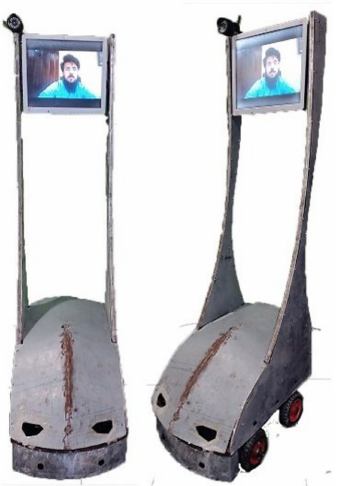
Figure 7. Manufactured Working Telepresence Robot Prototype. Our telepresence robot prototype is a robotic platform designed to facilitate remote communication and control in real-time. The proposed approach of the hybrid of DDQN and GRU can be implemented and tested on our manufactured robot to gather data and compare its performance with other approaches. The telepresence robot typically includes cameras, sensors, and actuators that allow a remote user to view and interact with the physical environment. The robot’s movement and actions can be controlled through a user interface, such as a joystick, keyboard, or touch screen.